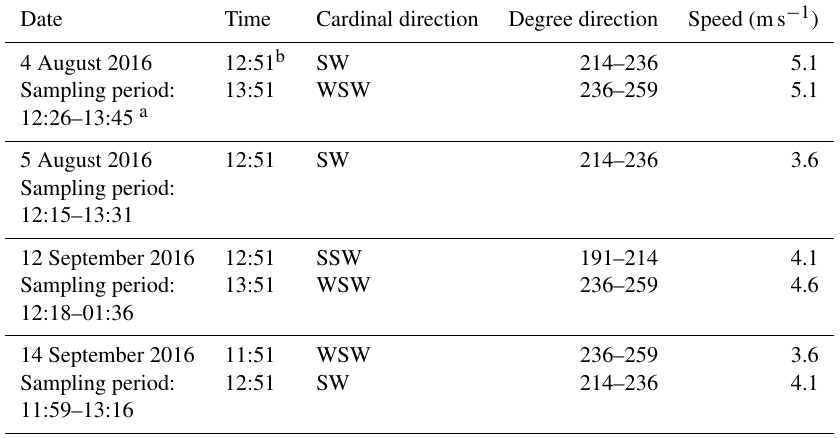
Table 1. Observed wind speed and direction for Santa Monica airport, which is 3.9km (2.4mi) from the near-roadway measurement site. Times shown are within 15min of the near-roadway sampling